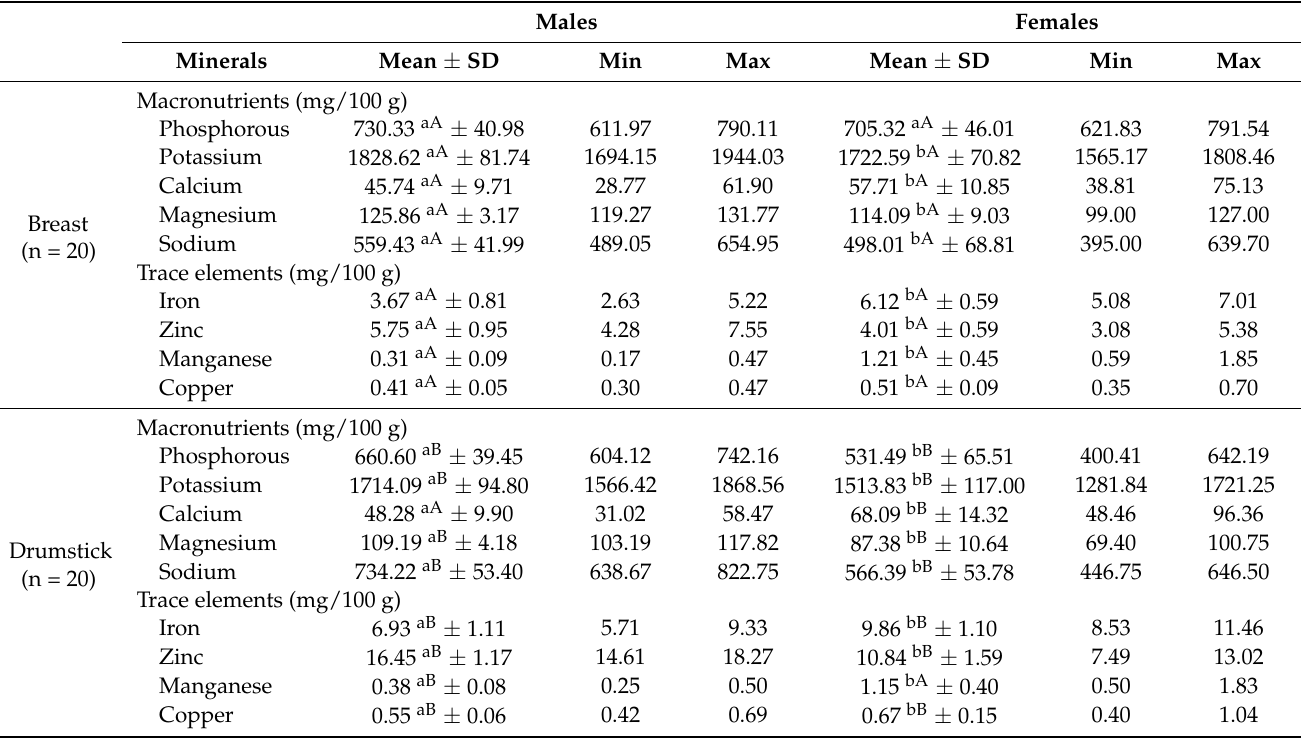
Table 5. Mineral composition of the breast and drumstick meat from the males and females of the “Branca” breed (mean ± SD, Min and Max) (results expressed in mg/100 g of dry weight). Males